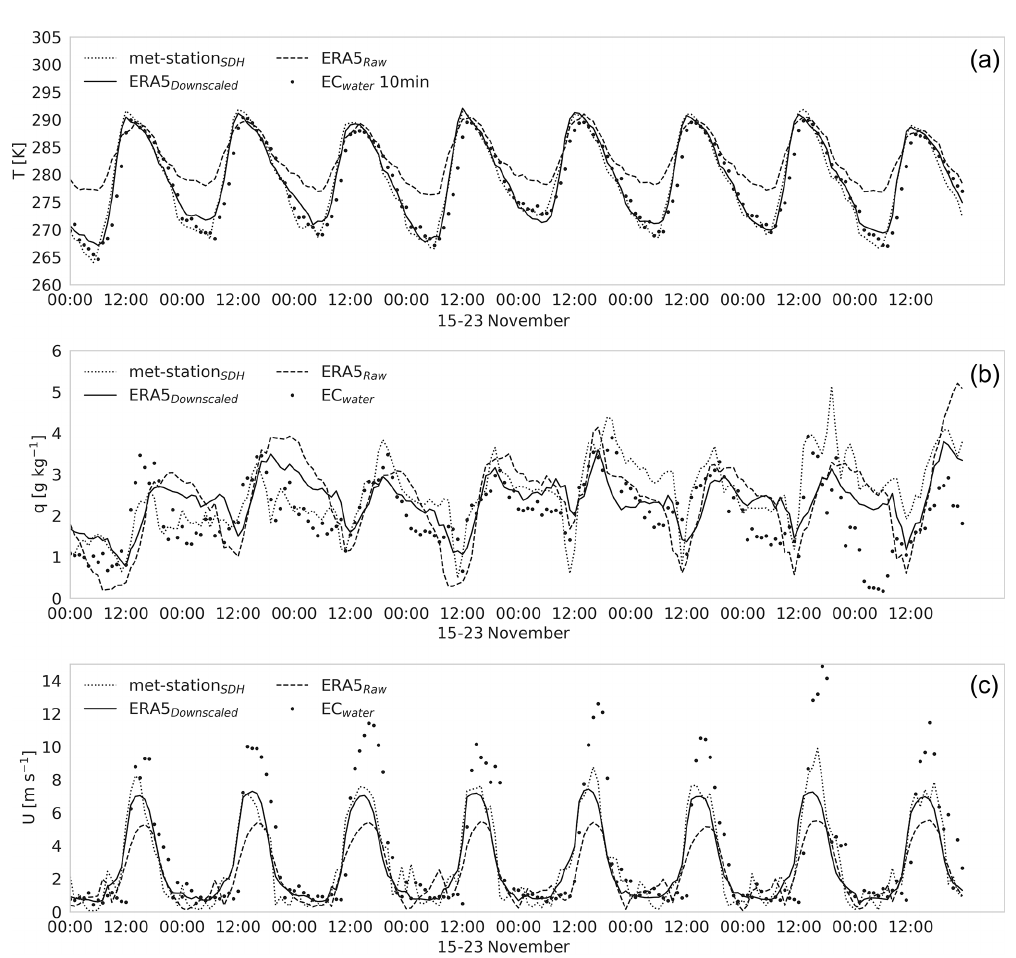
Figure 2. (a) Data comparison of air temperature ( T ), (b) specific humidity ( q ) and (c) wind speed ( U ) between the available data sources: observations gathered from an eddy covariance (EC) over water surface (EC water ); observations collected from a meteorological station overland (met-station SDH ); ERA5 reanalysis raw data (ERA5 raw ); and ERA-5 reanalysis downscaled data (ERA5 down ).